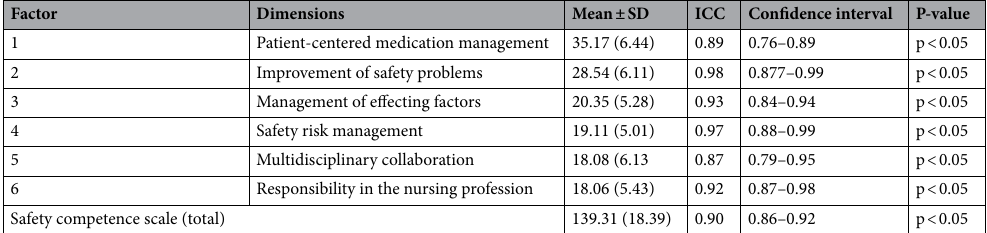
Table 4. Mean (standard deviation) and intraclass correlation coefficient (ICC) values for the domains of the medication safety competence scale